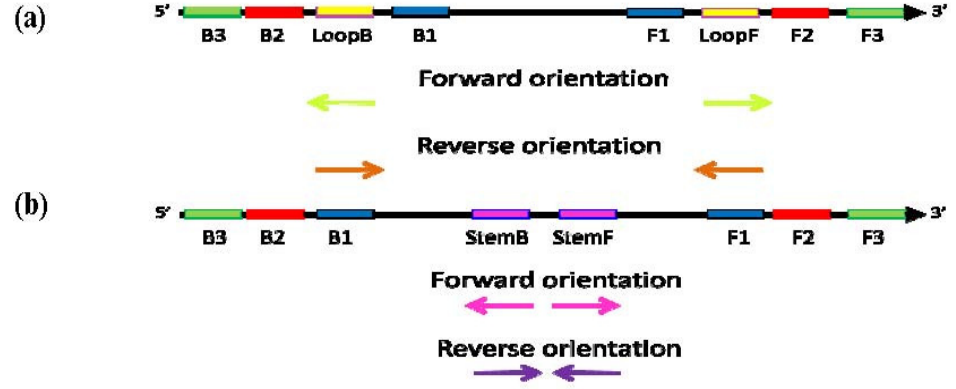
Figure 7. Schematic diagram of the “forward” (conventional) and “reverse” orientation of Loop primers in LAMP-LOOP ( a ); Stem primers in STEM-LAMP ( b ) and comparison of LAMP-LOOP with Loop primers in conventional (lime) and reverse (orange) orientation ( c ) and STEM-LAMP with Stem primers in conventional (pink) and reverse (purple) orientation ( d ) for 10, 1000 and 100,000 copies of inlA-AT construct (all dilutions were measured and detected in triplicate unless indicated otherwise). Final primers concentrations were: Lm-BIP, Lm-FIP, Lm-StemB, Lm-StemF, Lm-LoopB, Lm-LoopF, rLm-StemB, rLm-StemF, rLm-LoopB, rLm-LoopF, Lm-DisplB and Lm-DisplF ― 0.8 µM each. Each set of data included three NTCs that remained clean throughout the duration of the assay and were not associated with any time-to-peak value (hence not shown graphically). Error bars represent standard deviations of triplicate